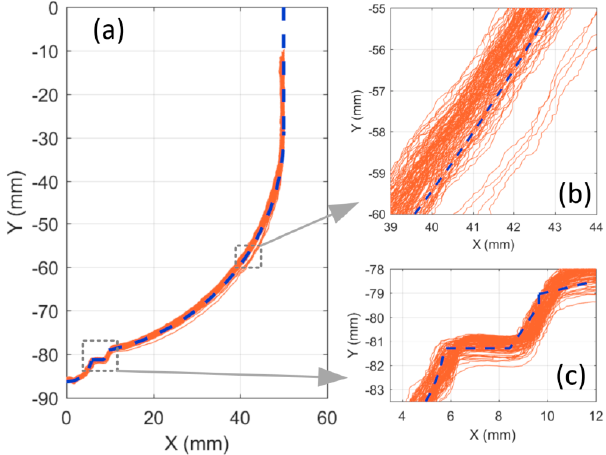
Figure 5. Recorded laser outlines at 120 different azimuths compared to the known breast model outline: overall outline ( a ), close up on the vertical section ( b ), and nipple detail ( c ).